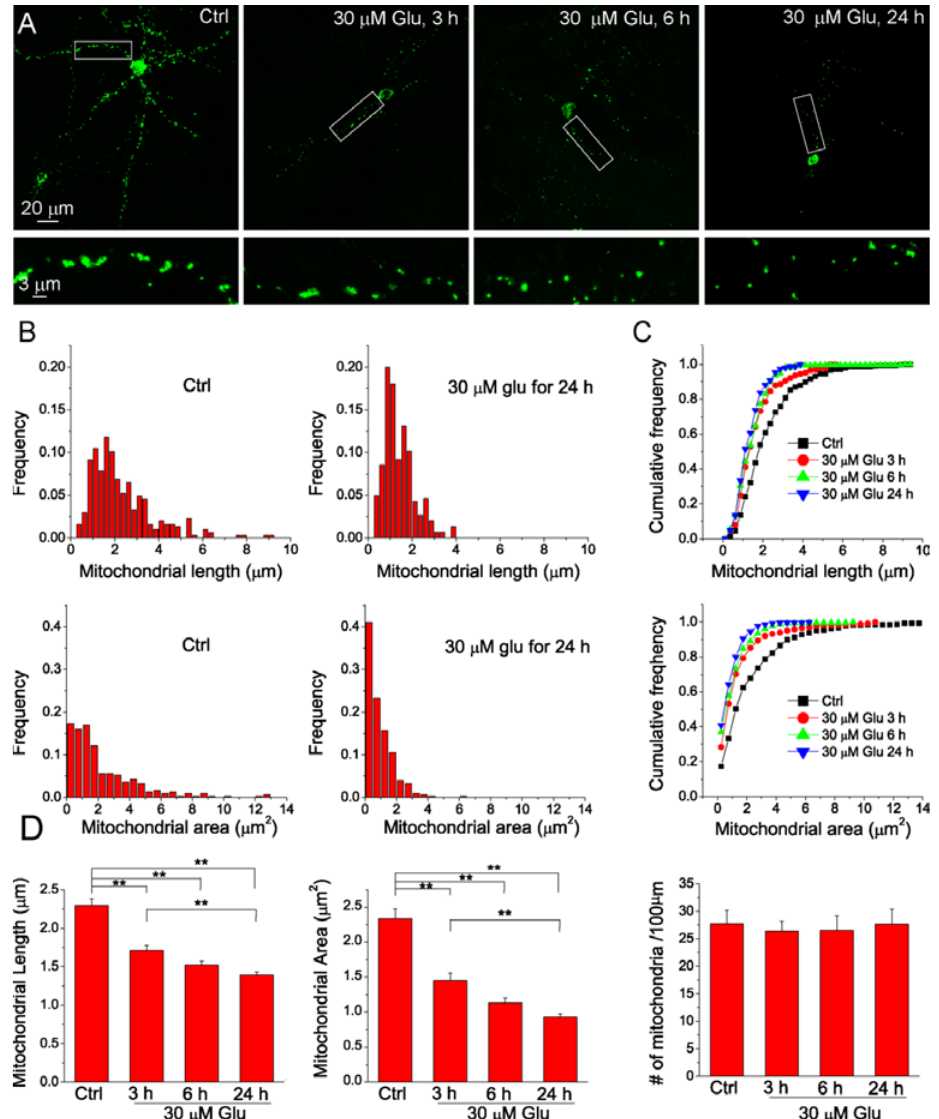
Figure 3. The time course of mitochondrial fragmentation after glutamate stimulation. ( A ) Maximal projection confocal images of primary cortical neurons transfected with mito-AcGFP1. Neurons were treated without or with 30 μM glutamate together with 3 μM glycine for 3, 6 and 24 h, respectively. The lower panels are the high resolution images of the boxed region in upper panels. The images at different time points were acquired from different neurons; ( B – C ) Frequency distribution and cumulative curves of mitochondrial length and area under different conditions. The values of histogram intervals (bins) are 0.25 μm for mitochondrial length and 0.5 μm 2 for mitochondrial area. Distribution data showed that glutamate treatment caused significant increase in the number of shorter and smaller mitochondria and this effect was dependent on treatment time; ( D ) The summary of average mitochondrial length, area and density for each condition. Data are shown as mean ± SE; ** p < 0.01, ANOVA test. Data were collected from 10–11 neurons grown on two glass coverslip per experimental condition and a total of 1169 mitochondria were